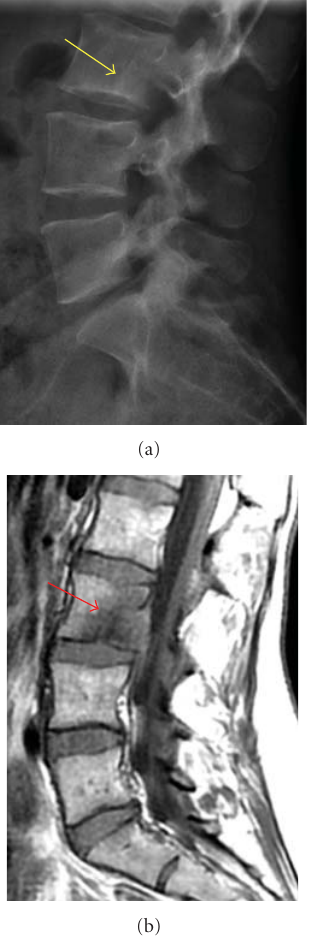
Figure 1: (a) Lateral radiograph is poor at delineating the L3 ver- tebral body metastatic lesion, which appears as a faint lucency with a subtle sclerotic margin (yellow arrow). (b) This lesion is better seen on the sagittal T1-weighted MRI as an ill-defined hypointensity (red arrow) within the L3 marrow.